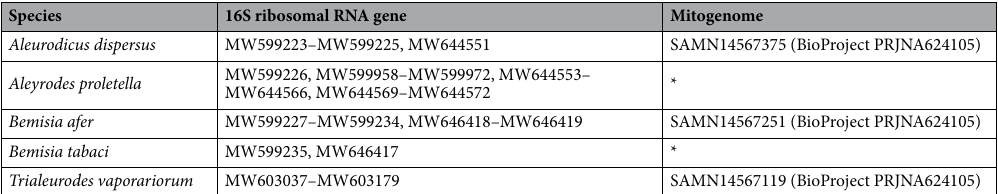
Table 1. Summary of the assigned GenBank accessions of samples/sequences generated in this study. *Partial